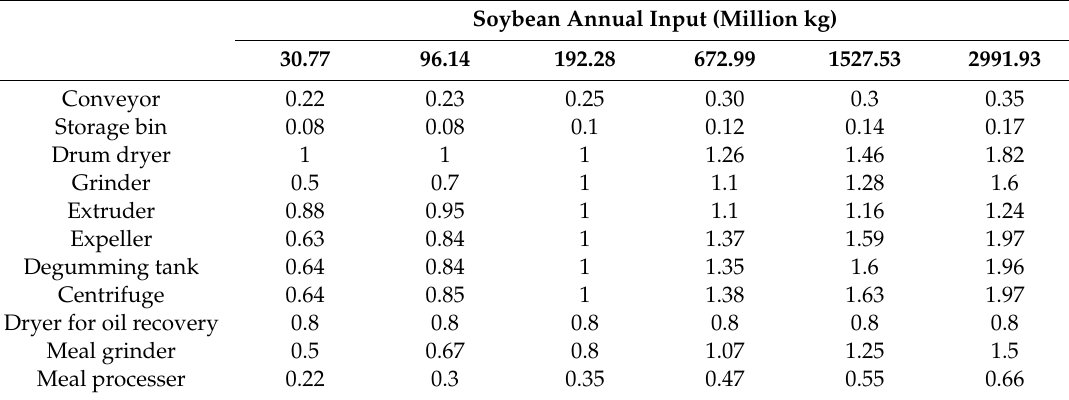
Table 4. Labor requirements for each operating facility (workers / unit / shift).